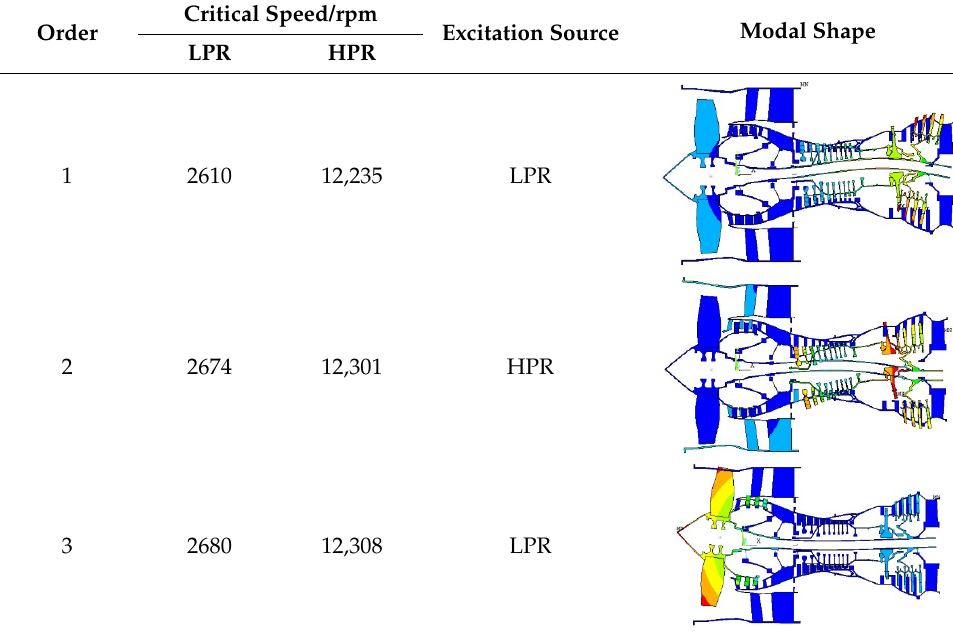
Table 8. The critical speed and mode shape of the whole engine after optimization. Order